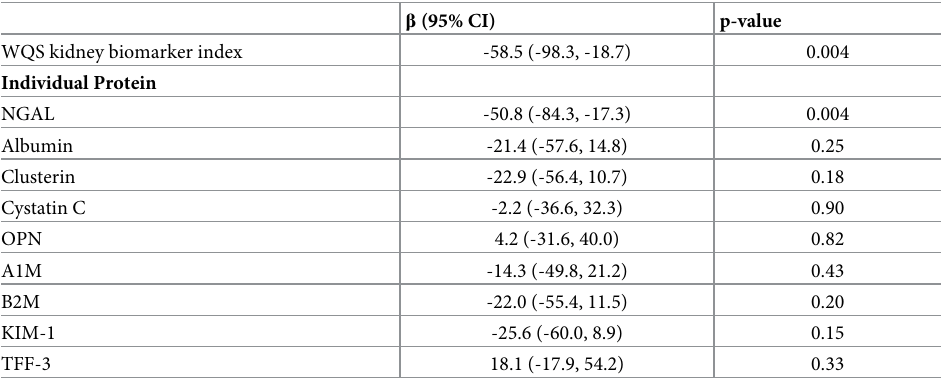
Table 4. Birth weight in grams per decile increase in the individual proteins and kidney biomarker index. These linear regression models were adjusted for child sex, age, BMI, indoor smoking, and urinary